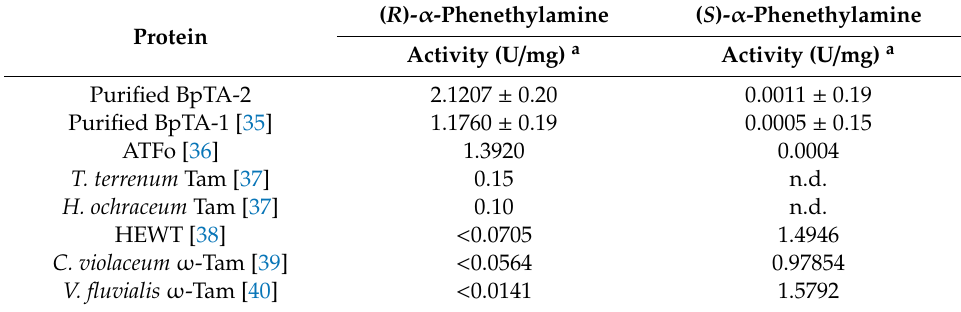
Table 1. BpTA-2 and other TAms specificity with ( R )- α -phenethylamine or ( S )- α -phenethylamine as an amino donor.